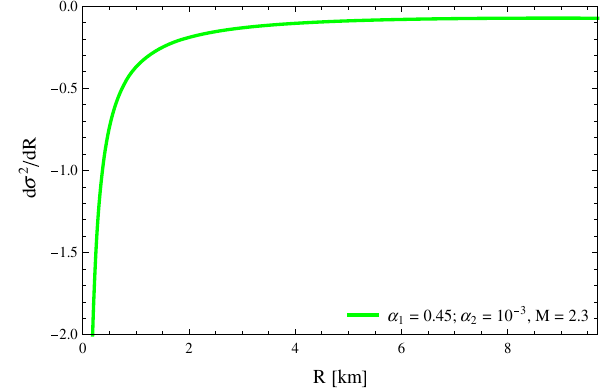
Fig. 9 Plots of the dimensionless parameter d σ 2 / dR as function of R for spherical object PSR